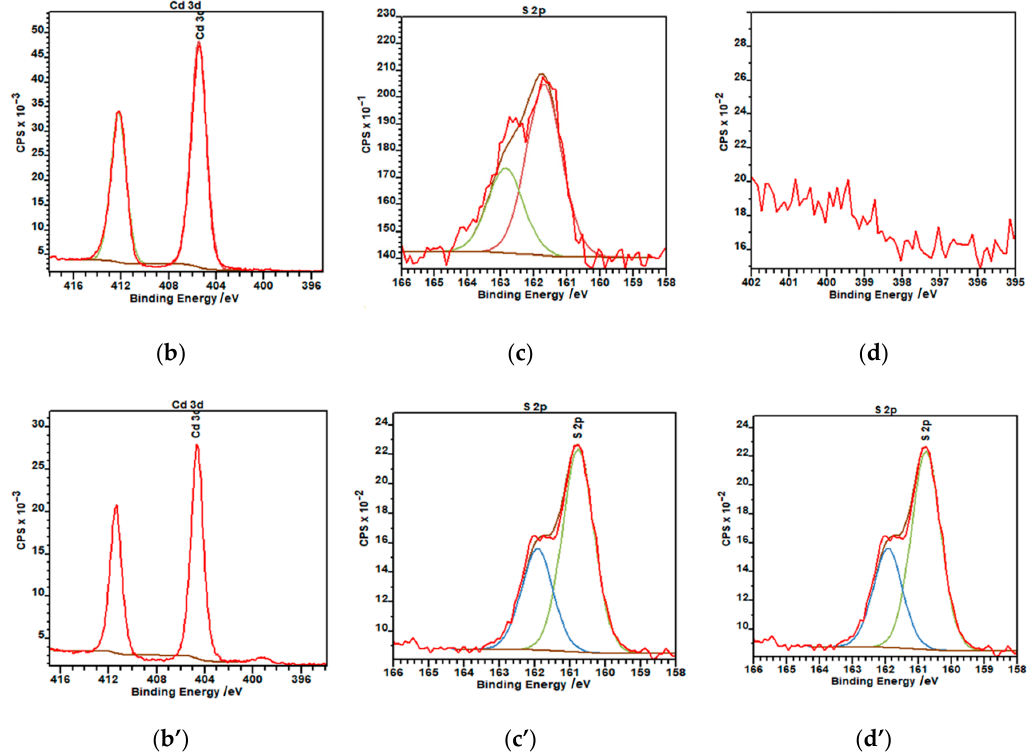
Figure 3. X-ray photoelectron spectroscopy (XPS) spectra of CdS nanoparticles: ( a, a’ ) survey spectra of hydrophilic and hydrophobic nanoparticles, respectively; ( b ) Cd 3d region; ( c ) S 2p region; ( d ) N 1s region for hydrophilic NPs; ( b’ ) Cd 3d region; ( c’ ) S 2p region; and (d’) N 1s region of oleylamine-coated CdS nanoparticles. Red curve – experimental data, green/blue curve – fitting curves.